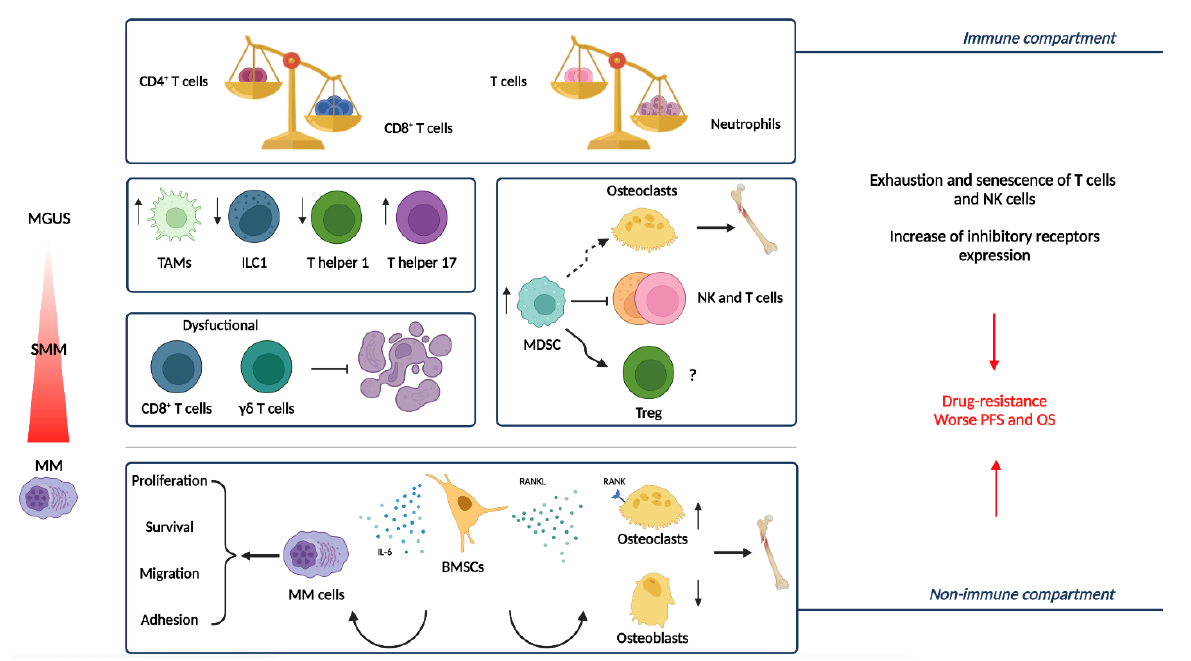
Figure 2. The immune and non-immune compartment of the Bone Marrow Niche in the progression from MGUS and SMM to active MM [25]. Representation of the main actors of the BM niche and the modification they undergo during disease evolution [26]. MM is characterized by quantitative and functional abnormalities related to immune cells such as inverted the CD4 + /CD8 + T cell and T cells/neutrophils ratio. TAMs more dramatically increase in patients with advanced MM than in those with MGUS, supporting tumor cell proliferation and drug resistance. Moreover, as MM progresses, Th1 and ILC1 decrease, while Th17 increase. Due to the inhibition of T and NK cell activation and effector functions, as well as the promotion of Treg development or their differentiation into osteoclasts, MDSCs play a role in the progression of MM by obstructing the anti-tumor immune response and causing osteolytic lesions. Dysfunctional effector functions of cytotoxic T cells (e.g., CD8 + T cells and γδ T cells) contribute to impaired anti-tumor immune response. Among non-immune cells, BMSCs play a critical role in MM pathogenesis by cell contact, secretion of cytokines, growth factors, and extracellular vesicles. Osteoclast precursors differentiate into bone-resorbing osteoclasts due to the interaction between RANKL, expressed by BMSCs and upregulated during MM progression, and its receptor RANK on osteoclasts. BMSCs secrete cytokines, such as IL-6, that promote the expression of survival proteins, inducing the growth and survival of MM cells. These alterations, associated with exhaustion/senescence, and the increased expression of inhibitory receptors, cooperate to tumor growth, drug resistance, and immune escape in the context of MM. Abbreviations: MM, multiple myeloma; MGUS, monoclonal gammopathy of undetermined significance; TAMs, tumor-associated macrophages; MDSC, myeloid-derived suppressor cells; Th1, T helper 1; ILC1, innate lymphoid cells 1; Th17, T helper 17; Treg, T regulatory cells; BMSCs,